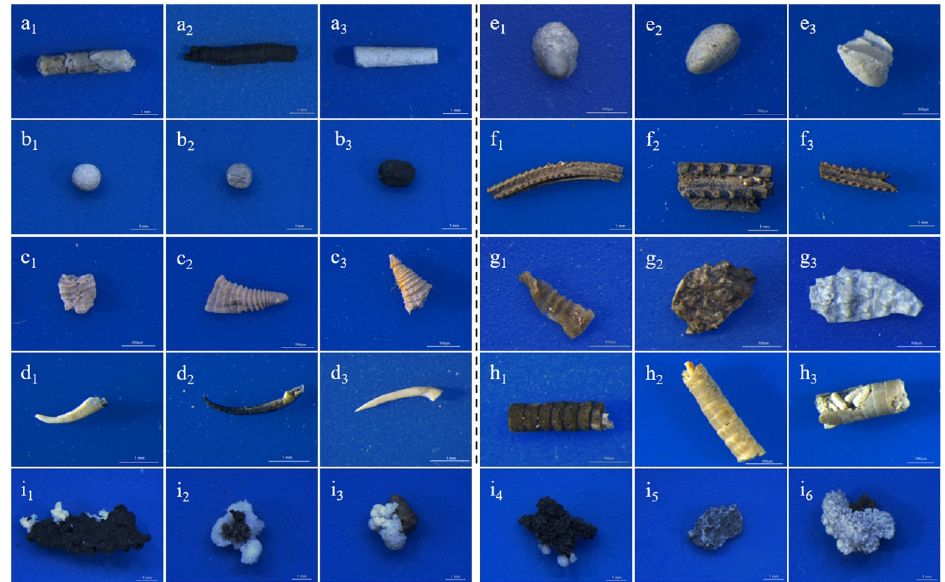
Figure 1. Image information on nine microfossil taxa. ( a1 – a3 ) Conotheca (scale bar: 1 mm); ( b1 – b3 ) Archaeooides (scale bar: 1 mm); ( c1 – c3 ) Quadrapyrgites (scale bar: 500 μ m); ( d1 – d3 ) Protohertzina (scale bar: 1 mm); ( e1 – e3 ) Maikhanella (scale bar: 500 μ m); ( f1 – f3 ) Carinachites (scale bar: 1 mm); ( g1 – g3 ) Qinscolex (scale bar: 500 μ m); ( h1 – h3 ) Hyolithellus (scale bar: 500 μ m); ( i1 – i6 ) Irregular-shaped dross (scale bar: 1